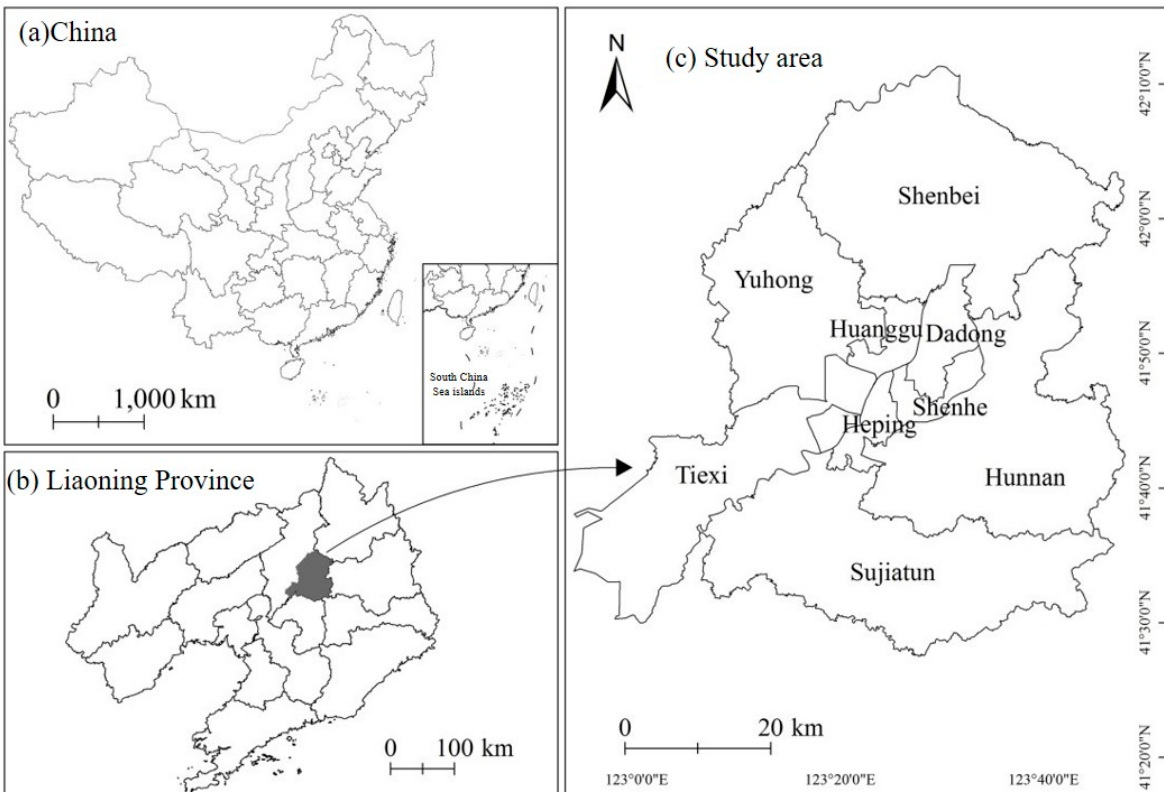
Figure 1. Location of study area.